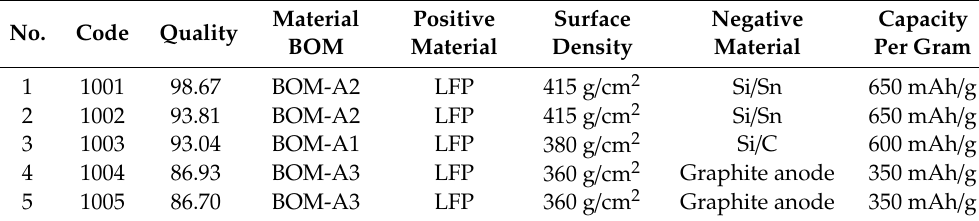
Table 10. Correspondence between battery quality and material information.